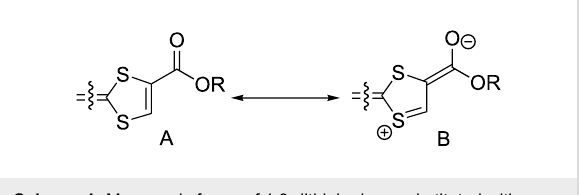
Scheme 1: Mesomeric forms of 1,3-dithiole rings substituted with